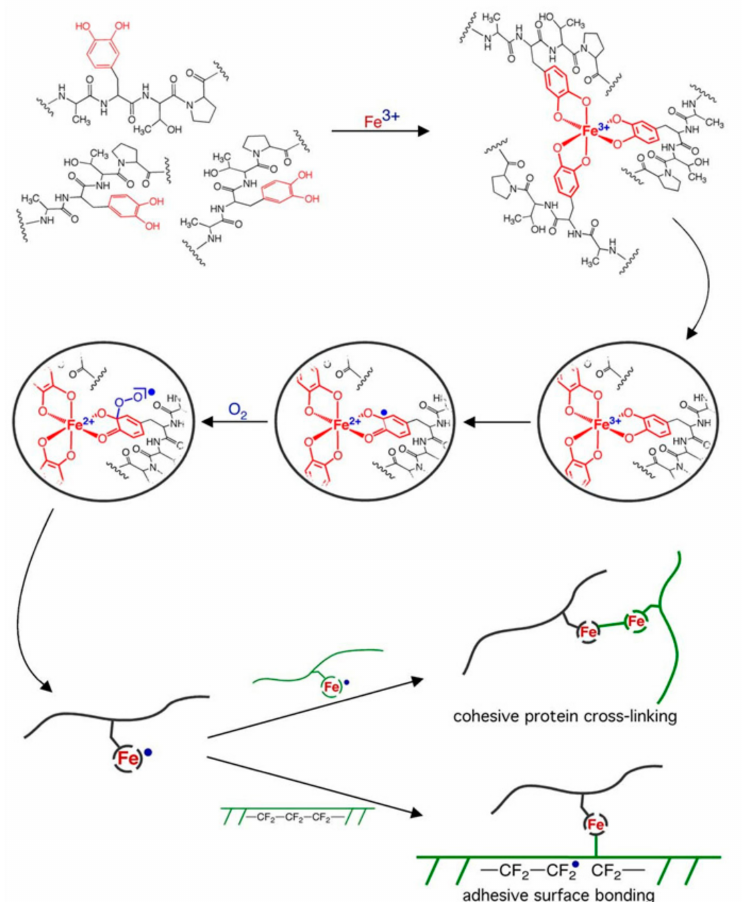
Figure 3. Adhesion mechanism of iron-induced 3,4-dihydroxyphenylalanine (DOPA). Reproduced with permission from Ref. [53], Copyright 2009, Elsevier